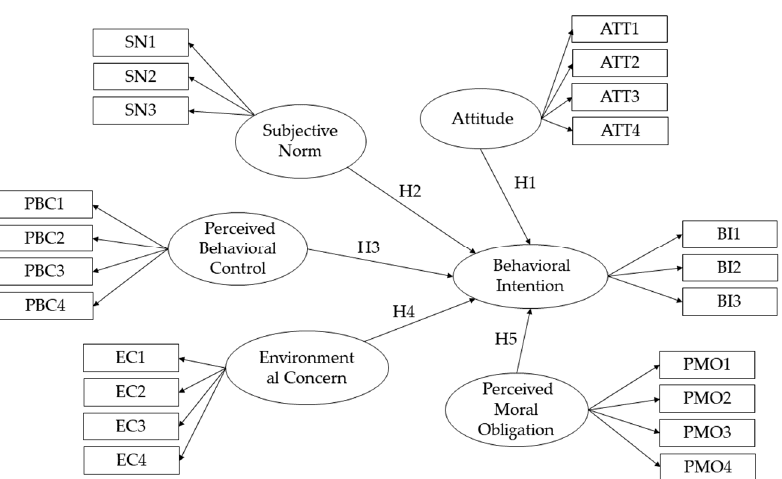
Figure 1. Expanded theory of planned behavior (E-TPB) model and survey items of E-TPB varia- bles.